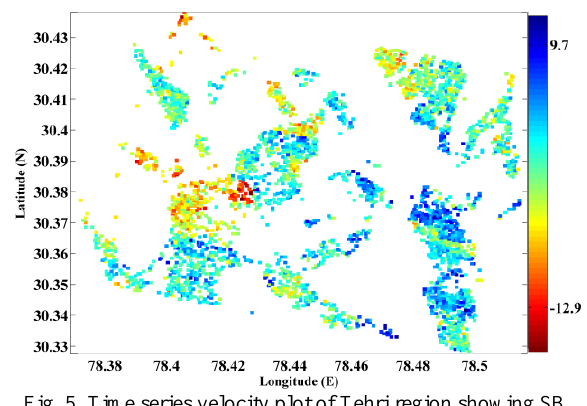
Fig. 5. Time series velocity plot of Tehri region showing SB pixels (colour bar showing velocity in